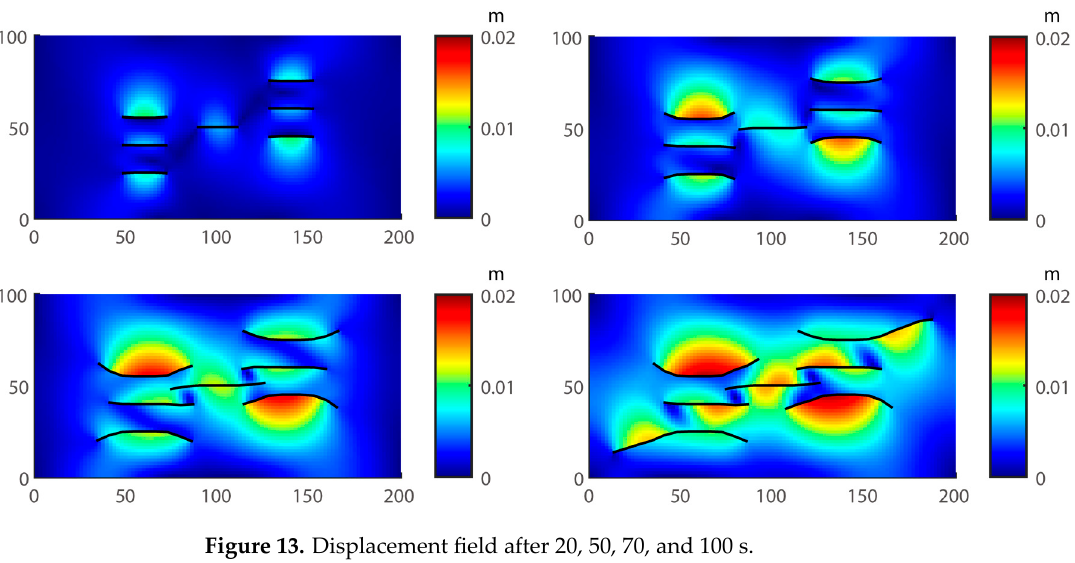
Figure 13. Displacement field after 20, 50, 70, and 100 s.